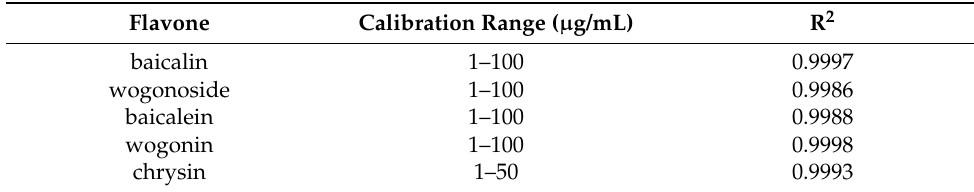
Table 4. Calibration curve